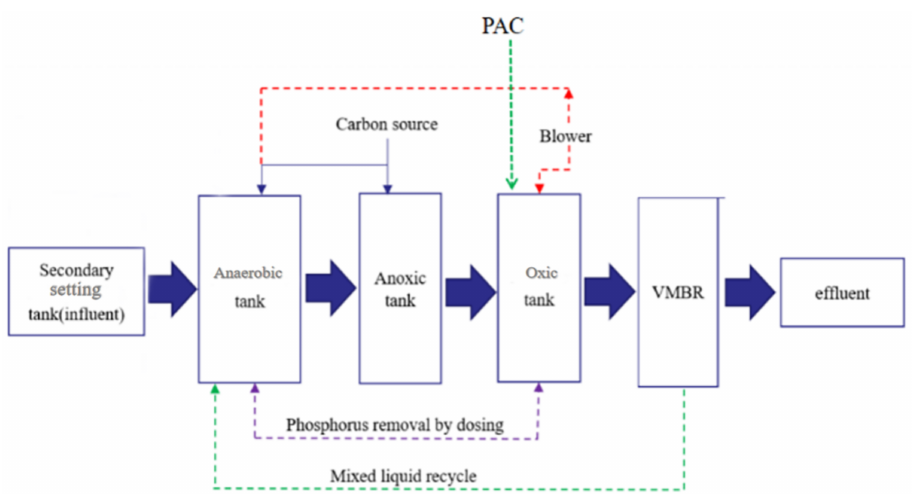
Figure 1. Integrated sewage treatment equipment.